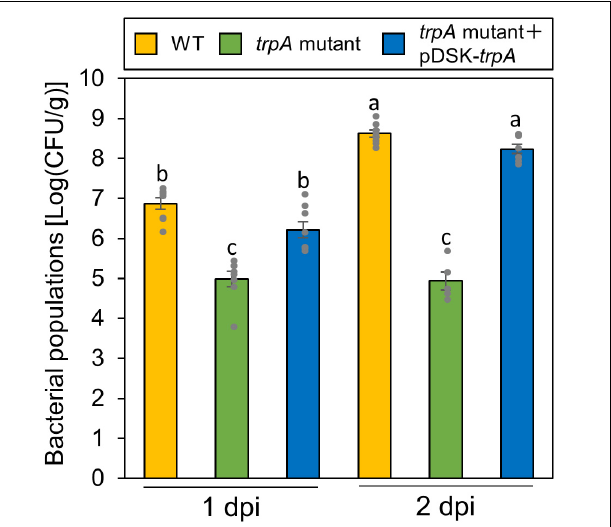
FIGURE 3 | Epiphytic bacterial populations of Pseudomonas cannabina pv. alisalnesis KB211 WT and the trpA mutant on cabbage after flood-inoculation. Cabbage seedlings were flood-inoculated with 1 × 10 8 CFU/ml of WT, the trpA mutant, and the trpA mutant complemented with pDSK- trpA containing 0.025% SilwetL-77. Epiphytic bacterial populations were determined by washing the leaves with washing buffer (50 mM PBS buffer) in an ultrasonic bath for 7 min, and then by plating dilutions to KB agar medium. Bacterial concentrations on the leaf surface were evaluated at 1 and 2 dpi. Vertical bars indicate the standard error for at least five biological replicates. Different letters indicate a significant difference among treatments based on a Tukey’s HSD test ( p <